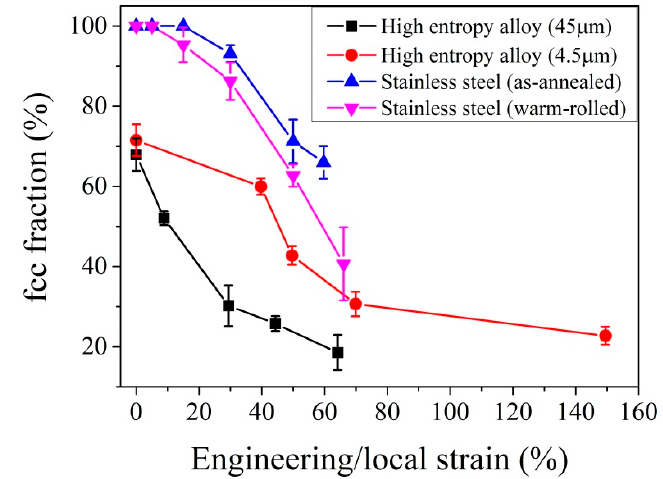
Figure 12. Evolution of austenite (face centered cubic, fcc) volume fraction with respect to strain for different alloys under varied grain size [207] or dislocation density [175].